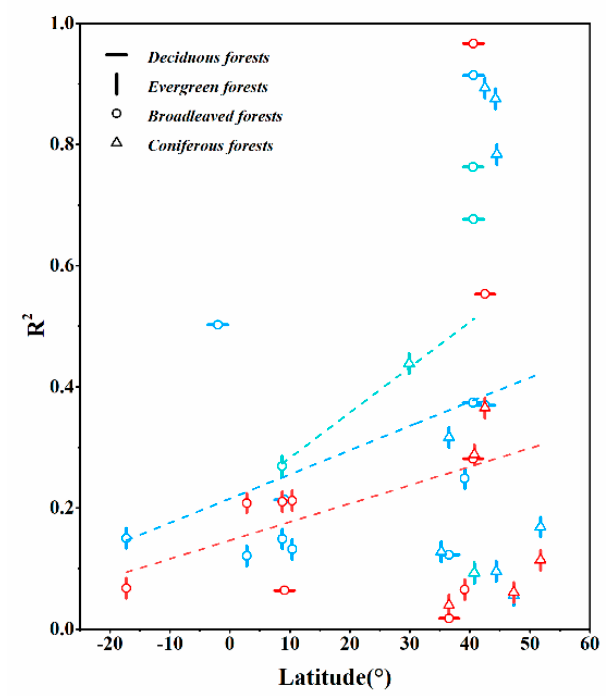
Figure 8. The coefficients of determination ( R 2 ) of relationships between N 2 O fluxes and NH 4+ concentration (blue, R 2 _NH4), NO 3- concentration (red, R 2 _NO3), and DOC concentration (green, R 2 _DOC), along the latitude gradient. The blue, red, and green dashed line represent the linear regression between R 2 _NH4 ( p > 0.05, n = 20), R 2 _NO3 ( p > 0.05, n = 15), R 2 _DOC ( p > 0.05, n = 5) and latitudes, respectively.